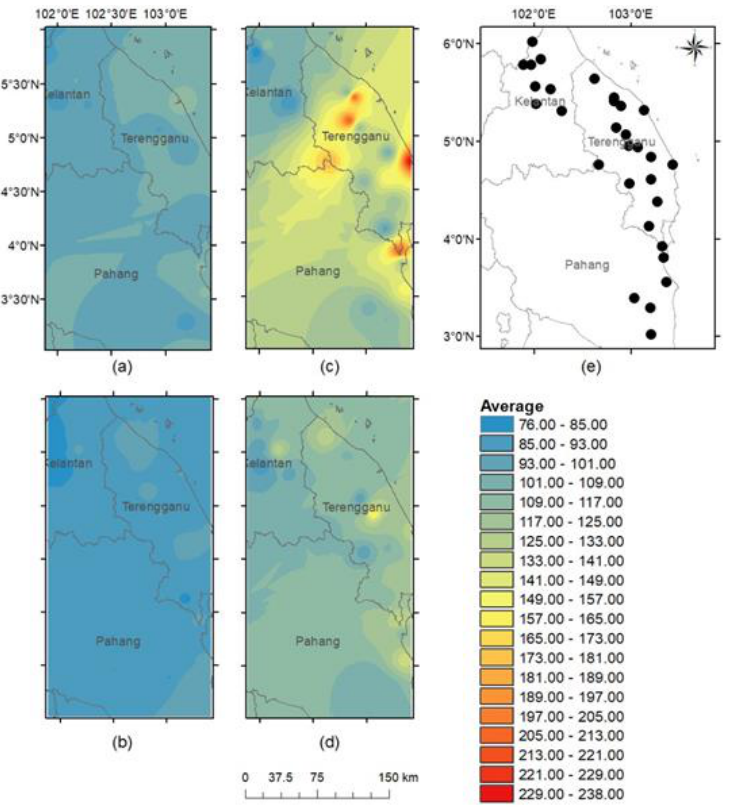
Figure 8. Torrential rainfall composites on the East Coast of Peninsular